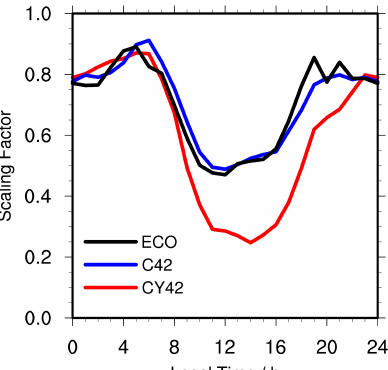
Figure 4. Hourly ratios of NO 2 measurements from the Teledyne API model 200 eup photolytic NO x analyzer to NO 2 from coinci- dent catalytic instruments for 2011 July. “CY42” denotes the ra- tios of photolytic NO 2 to NO 2 from the Thermo Electron 42C-Y NO y analyzer in Edgewood, “C42” denotes the ratios of photolytic NO 2 to NO 2 from the Thermo Model 42C NO x analyzer in Pado- nia, and “ECO” denotes the ratios of photolytic NO 2 to NO 2 from the Ecotech Model 9841 T-NO y analyzer in Padonia. “ECO” ratios are also used to scale NO 2 measurements from the Ecotech Model 9843 T-NO y